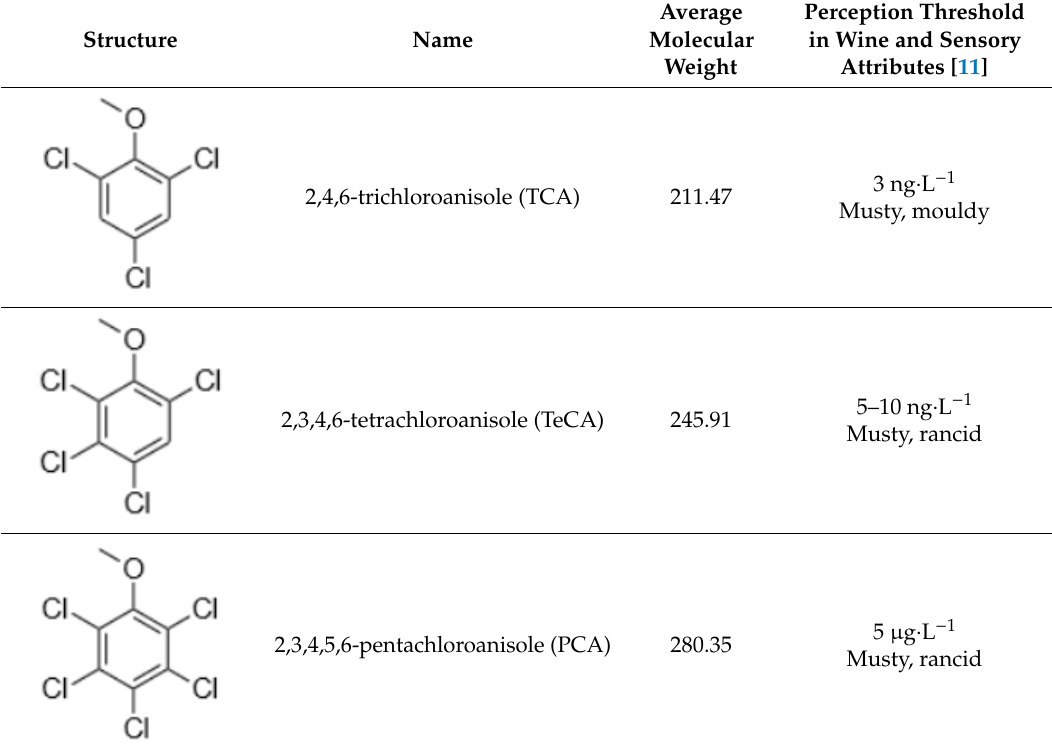
Table 1. Structures, molecular weights and perception threshold of chloroanisoles in wines. Structure